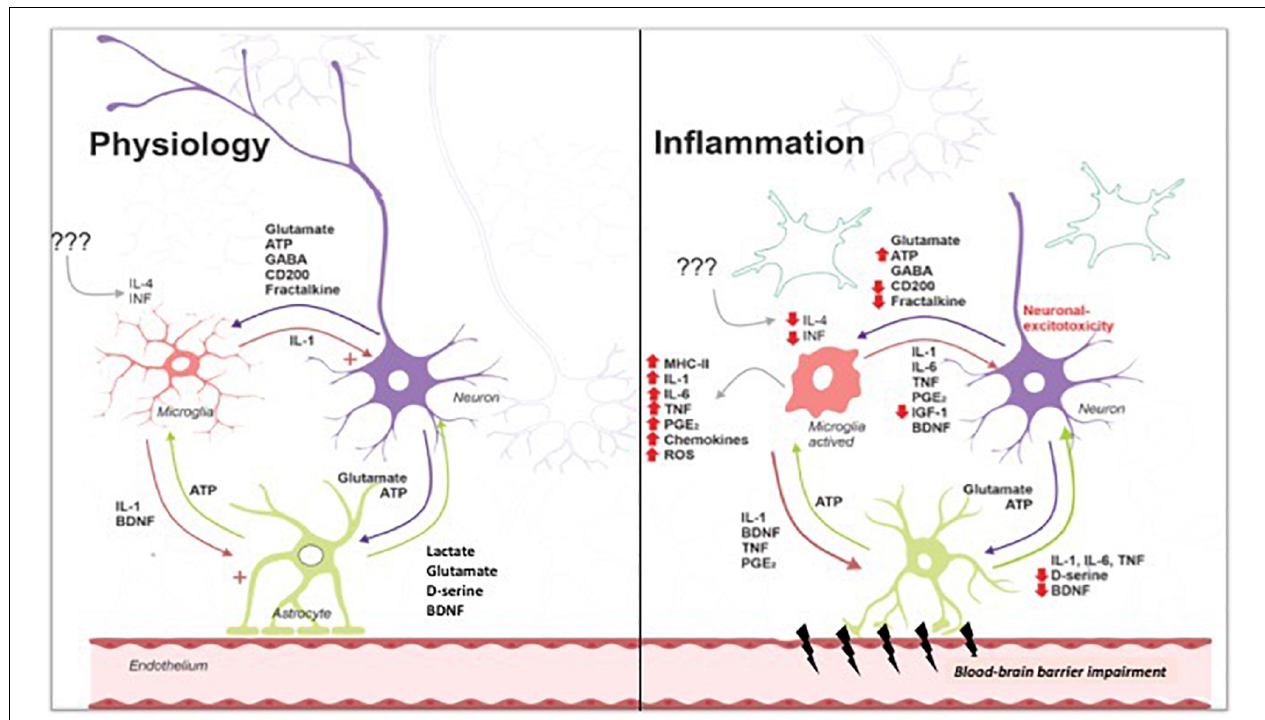
FIGURE 1 | Under physiological conditions, low levels of cytokines contribute to synthesis of proteins to crosstalk among neuron and glial cells. During infectious diseases, inflammation triggers endothelial activation and activation of immune cells. Cytokine/chemokine release leads to activation of blood vessels and blood–brain barrier breakdown. Glial cells (astrocytes and microglial cells) are activated, releasing cytokine/chemokine and reactive oxygen/nitrogen species. Activation of microglia exacerbates cell damage, especially neurons and endothelial cells. Astrocyte activation contributes to cytokines release and blood–brain barrier breakdown, reducing glutamate intake and leading to its accumulation on synaptic cleft. Excessive glutamate triggers excitotoxicity and neuronal death. Tripartite cross talk is lost, contributing to the development of neurological sequelae, in special, cognitive impairment. Image gently provided by Dr. Felipe